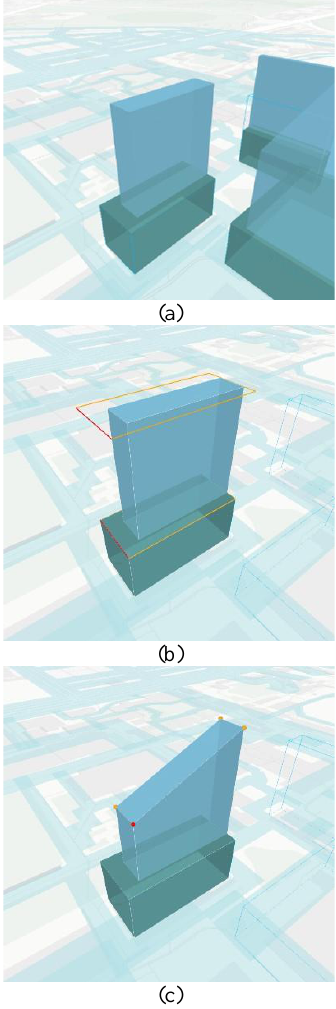
Figure 5. Generated 3D development envelopes,